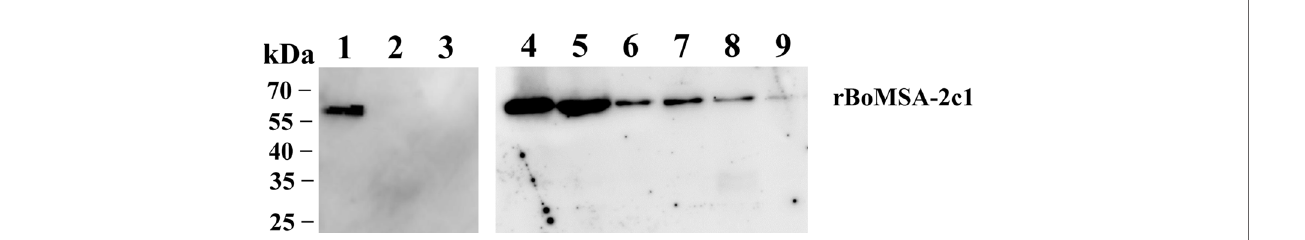
FIGURE 4 | Western blots of RBC binding to rBoMSA-2c1. Water buffalo RBCs (100 µL) binding to 1.0 mg/mL (lane 1) and (lane 2) 0 mg/mL of rBoMSA-2c1, and His-sumo (lane 3). Lanes 4 – 9, buffalo RBCs binding to rBoMSA-2c1 (1.6, 1.2, 0.8, 0.6, 0.4, and 0.2 mg/mL), respectively. His-sumo has been used as the negative control. All lanes exhibited reactions with